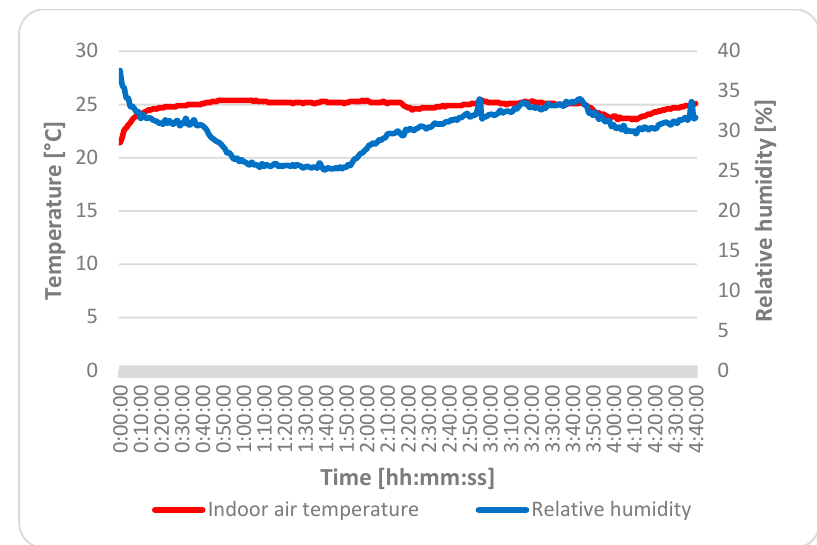
Figure 8. Course of measured values of indoor air temperature and relative humidity.